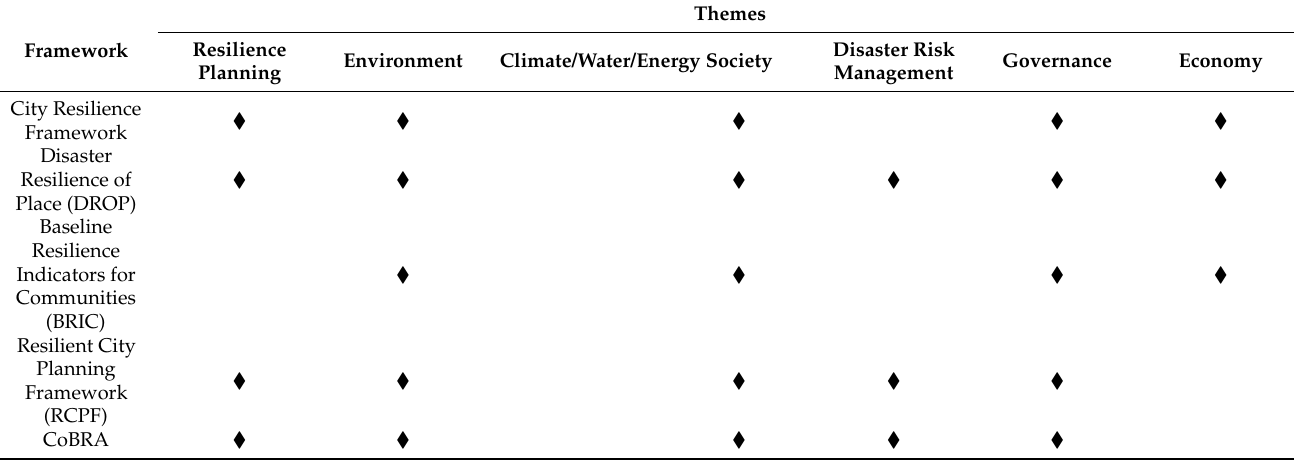
Table 2. Comparison of themes in resilient city frameworks.